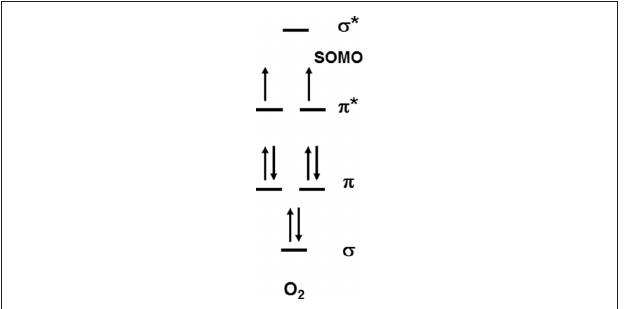
Figure 2 | The molecular orbital diagram for O filled orbitals that accept electrons.